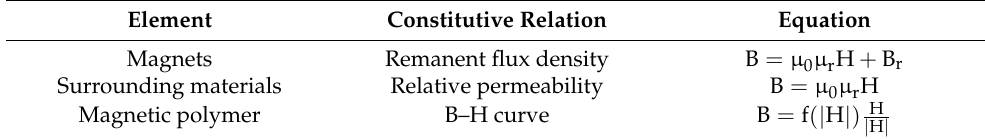
Table 1. Constitutive relations used in the first part of the model. Element Constitutive Relation Equation Magnets